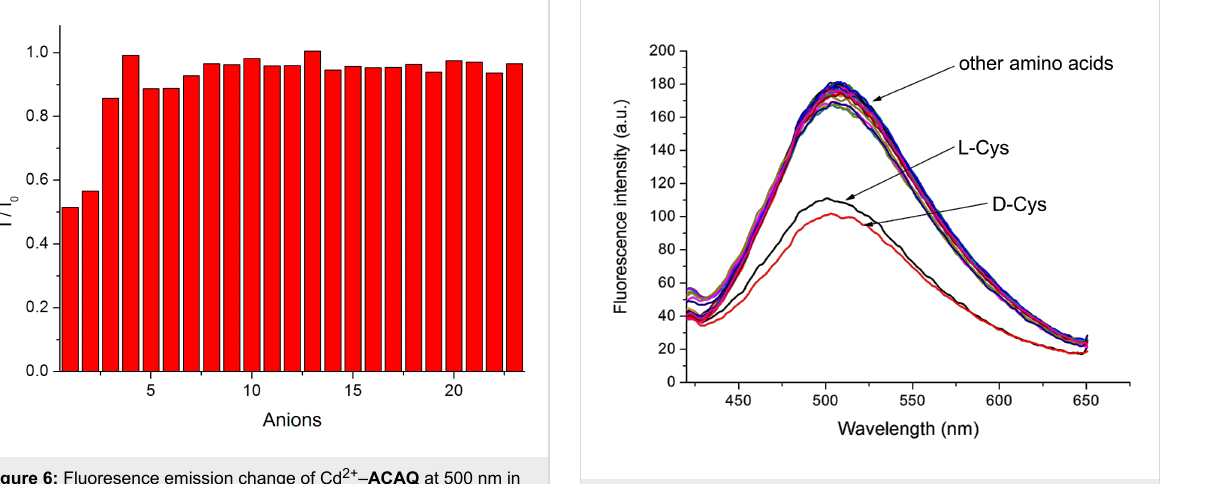
Figure 7: Fluorescence spectra of (10 µm) Cd 2+ – ACAQ upon the titra- tion of various amino acids in buffer solution (10 mM, HEPES, 1% ACN, pH 7.4) at 298 K (excitation at 350 nm). Other amino acids include: GSH; L-Met; DL-Hcy; N -Ac-L-Cys; MPA; L-Asp; D-Asp;